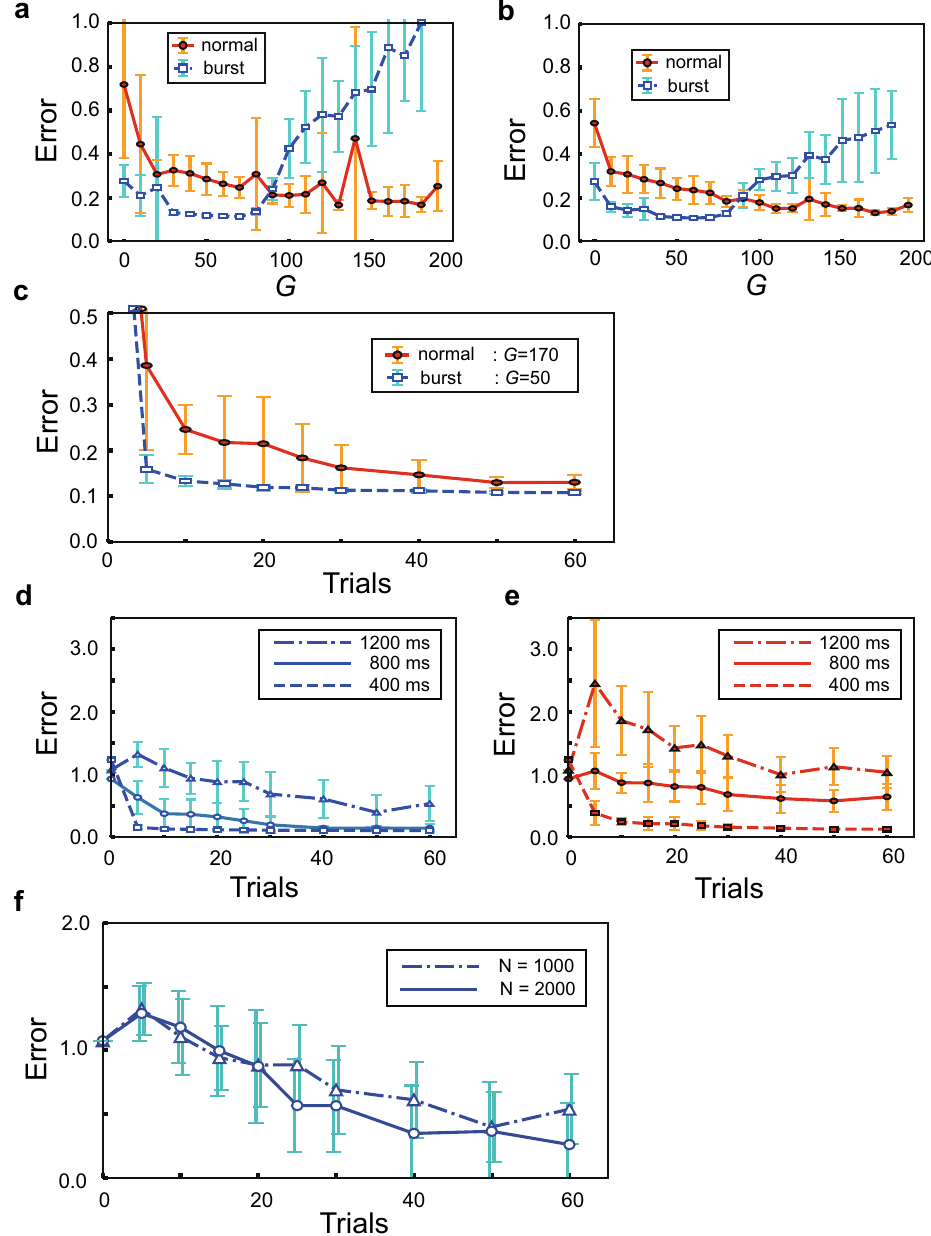
Figure 2. Learning in the burst vs. RS modes. ( a ) Errors in the bursting and RS modes are plotted against the strength of recurrent connections after 25 learning trials. Error bars show the standard deviations. ( b ) Similar errors are plotted after 50 learning trials. ( c ) The time courses of errors during learning are shown for the optimal coupling strengths of the individual modes. ( d , e ) Similar time courses are shown in the bursting ( d ) and RS ( e ) modes for target signals of lengths 400, 800, and 1200 ms. The plots for 400 ms are copied from ( c ). ( f ) Error time courses are shown in the bursting mode when the target length is 1200 ms and the reservoir size is 1000 or